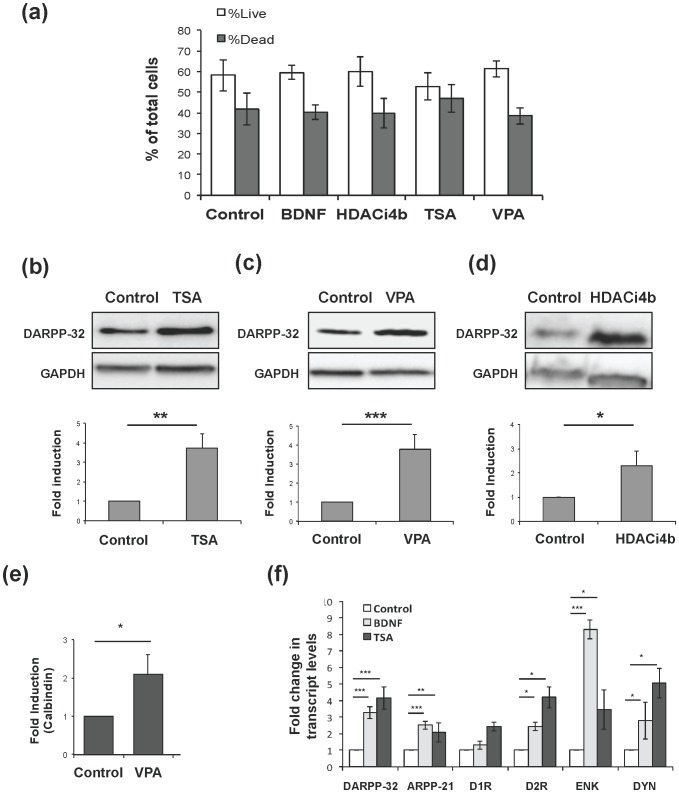
Trichostatin A, valproic acid and HDACi 4b up-regulate markers of the differentiated MSN but do not increase survival of striatal neurons in vitro.(a) Over 2,000 neurons were counted for each condition, derived from 3 separate platings. Untreated control, BDNF (10 ng/ml), HDACi 4b (5 µM), trichostatin A (10 nM) and valproic acid (3 mM), p = 0.94, one-way ANOVA. (b–d) Primary striatal neurons were treated with (b) TSA (10 nM), (c) VPA (3 mM), or (d) HDACi 4b (5 µM) for 24 h, each of which increased the level of DARPP-32 protein. Representative of 3 platings, each performed in duplicate. (e) Calbindin is increased after 24 h of treatment with VPA, (f) Transcript levels of DARPP-32, ARPP-21, D1 type receptors (D1R), D2 type receptors (D2R), encephalin (ENK) and dynorphin (DYN) were measured by RT-qPCR after 24 h treatment with BDNF or TSA. N = 5–8; +/− SEM (*p<0.05, **p<0.01, ***p<0.001).